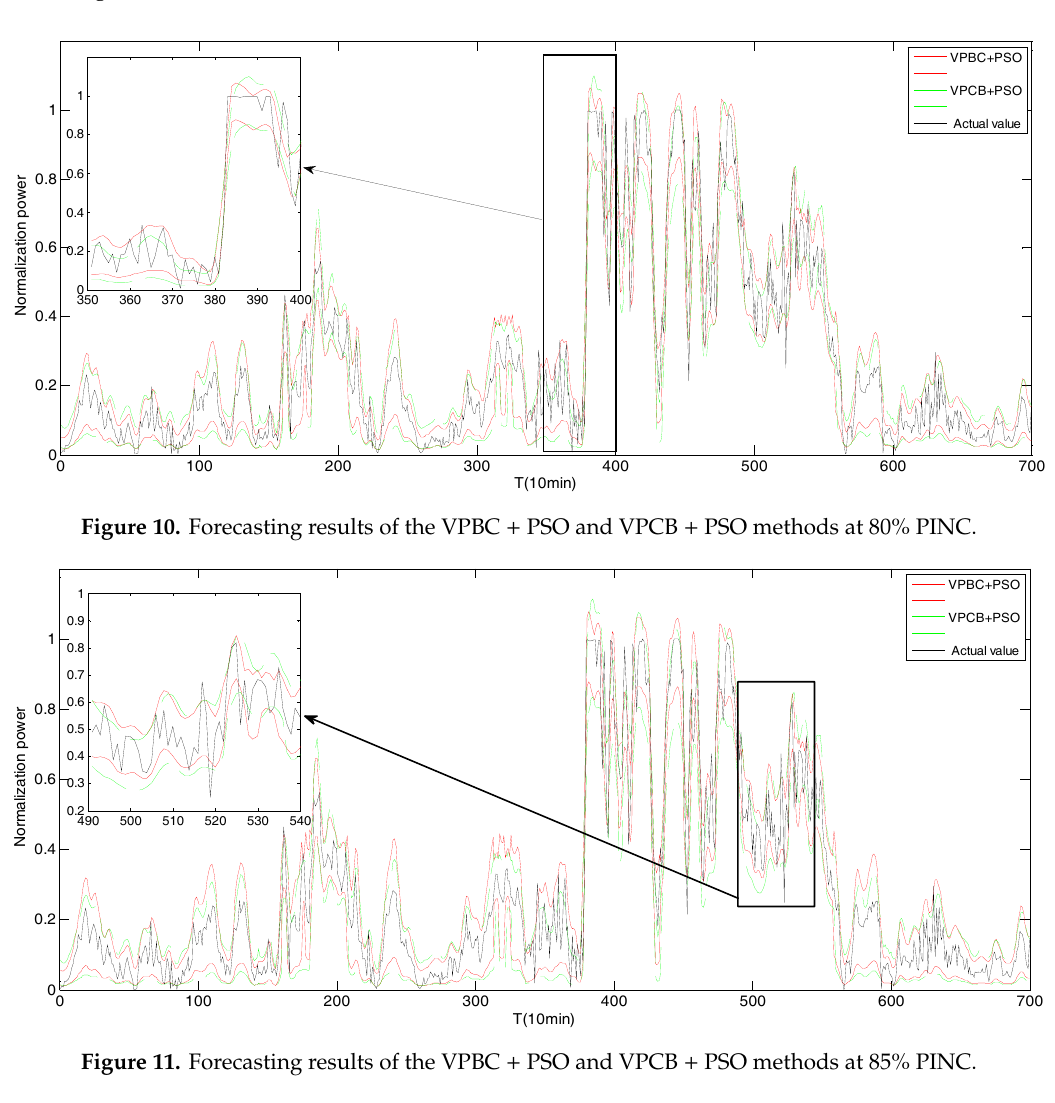
Figure 9. Forecasting results of the VPBC + PSO and CNN + PSO methods at 90% PINC.